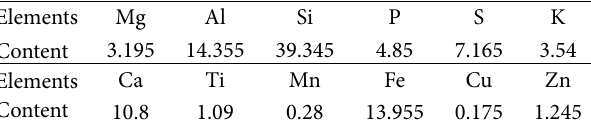
Table 1: Detection results of sludge